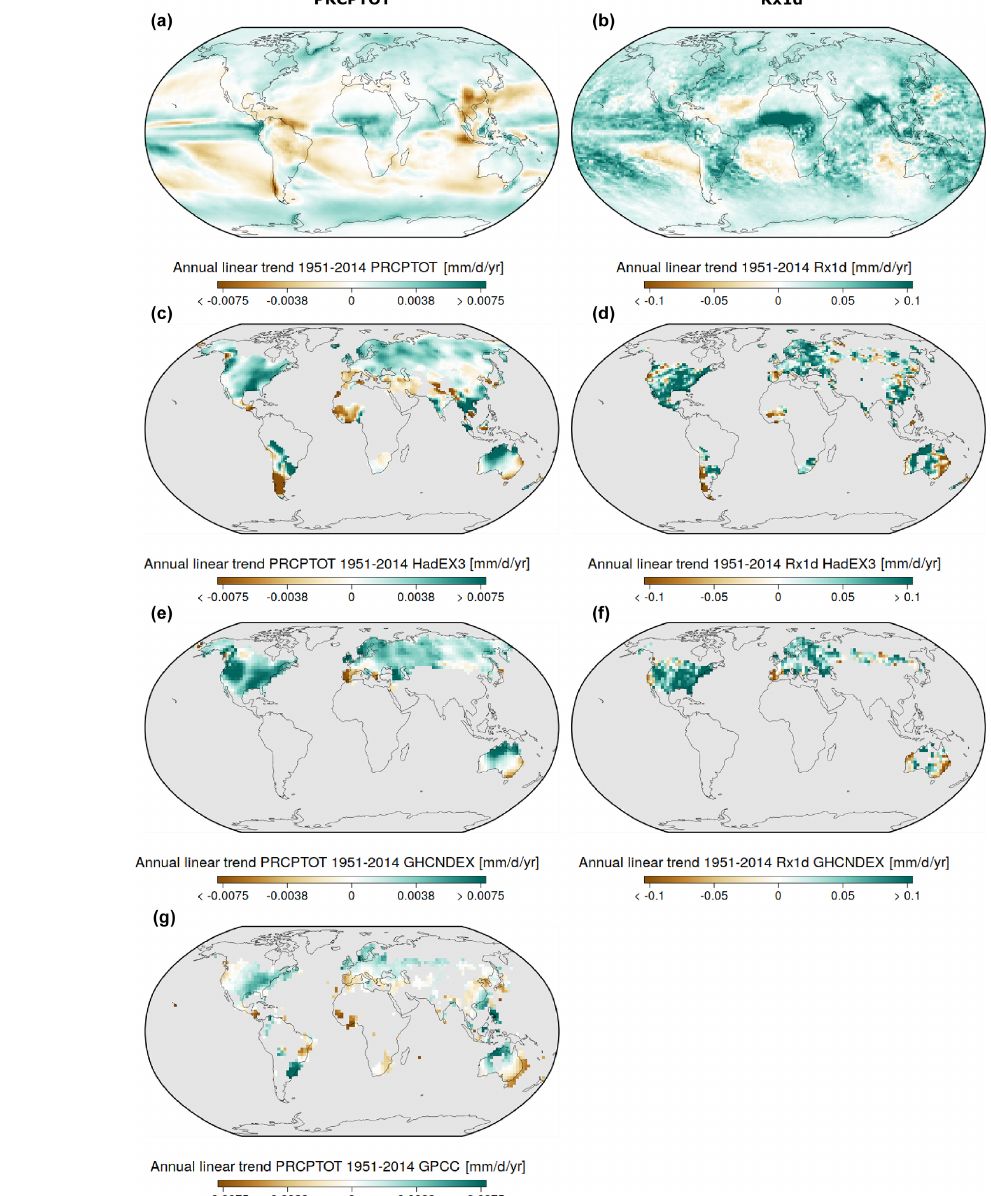
Figure 2. Mean total precipitation (PRCPTOT, a, c, e, g ) and extreme precipitation (Rx1d, b, d, f ) 1951–2014 annual linear trends in the CMIP6 multi-model mean (a, b) , in HadEX3 observational data (c, d) , in GHCNDEX observational data (e, f) , and in GPCC observational data (g)